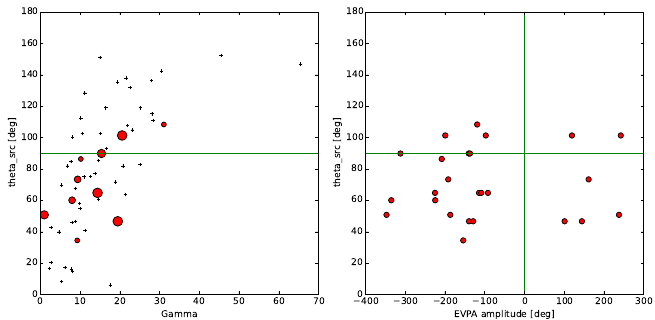
Figure 1. Left panel : Intrinsic viewing angle θ src vs. jet Lorentz factor Γ for a sample of bright blazars compiled by [17]. Blazars showing rotations of optical polarisation in the RoboPol survey are indicated with red circles, the size of which indicates the number of rotation episodes; Right panel : θ src vs. observed polarisation rotation amplitude for individual polarisation rotation